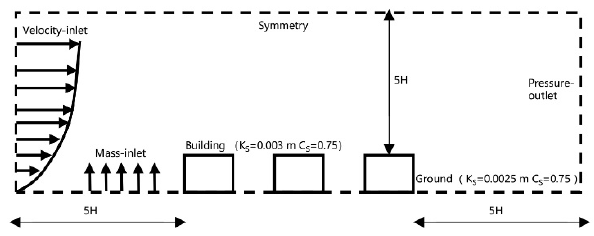
Figure 3. Calculation of domain boundary condition settings.